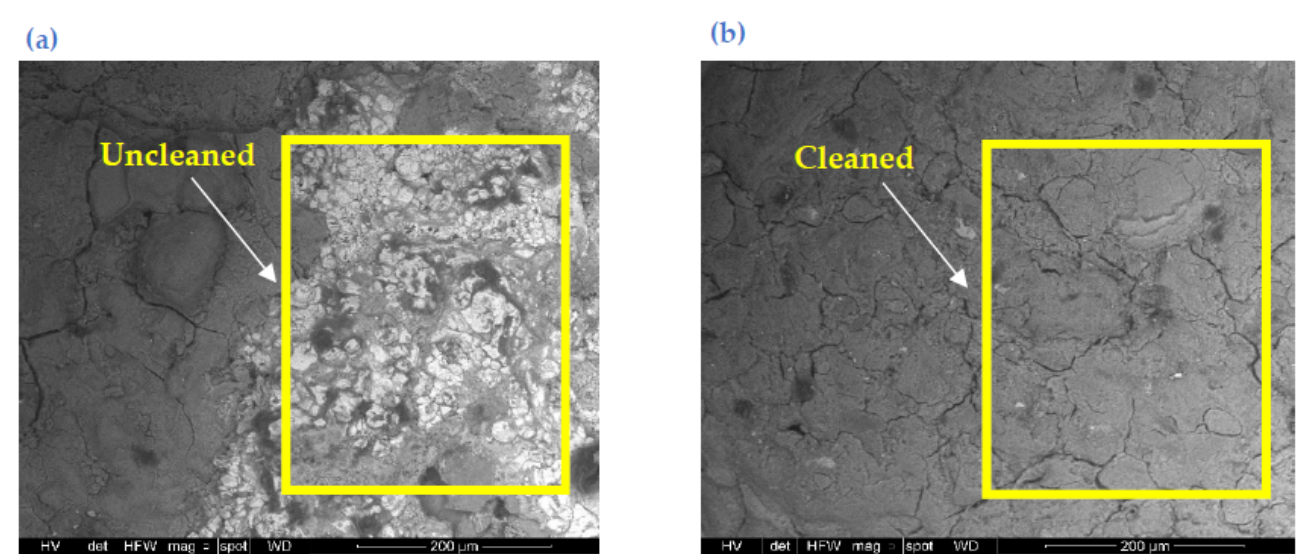
Figure 9. SEM image of sample (A) ( a ) before and ( b ) after cleaning at 500× magnification.